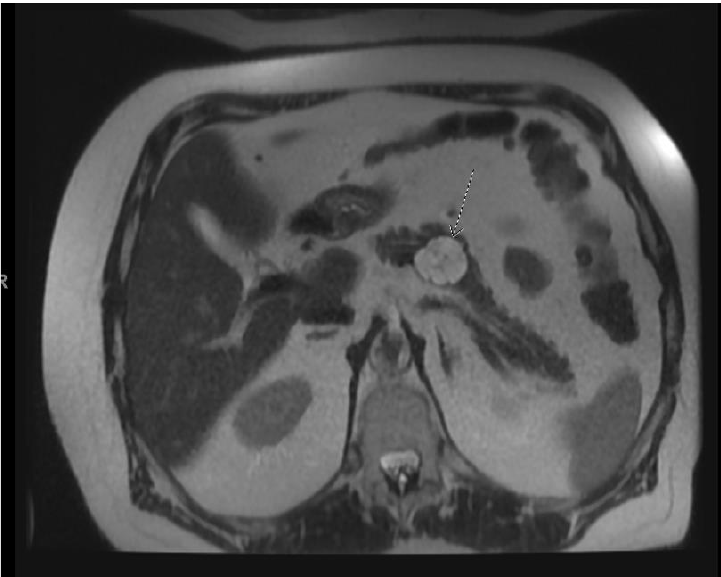
Figure 5. T2 weighted MRI of the abdomen demonstrating a serous cystic neoplasm with a central scar.